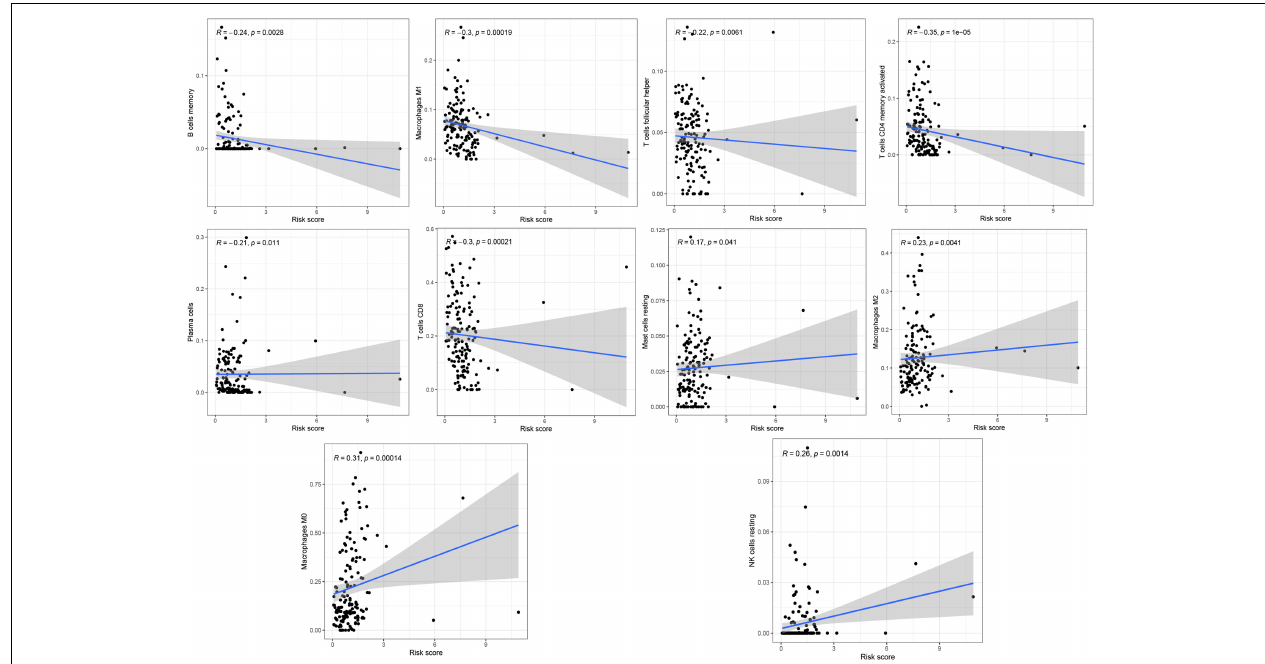
FIGURE 10 | The correlation between risk score and immune